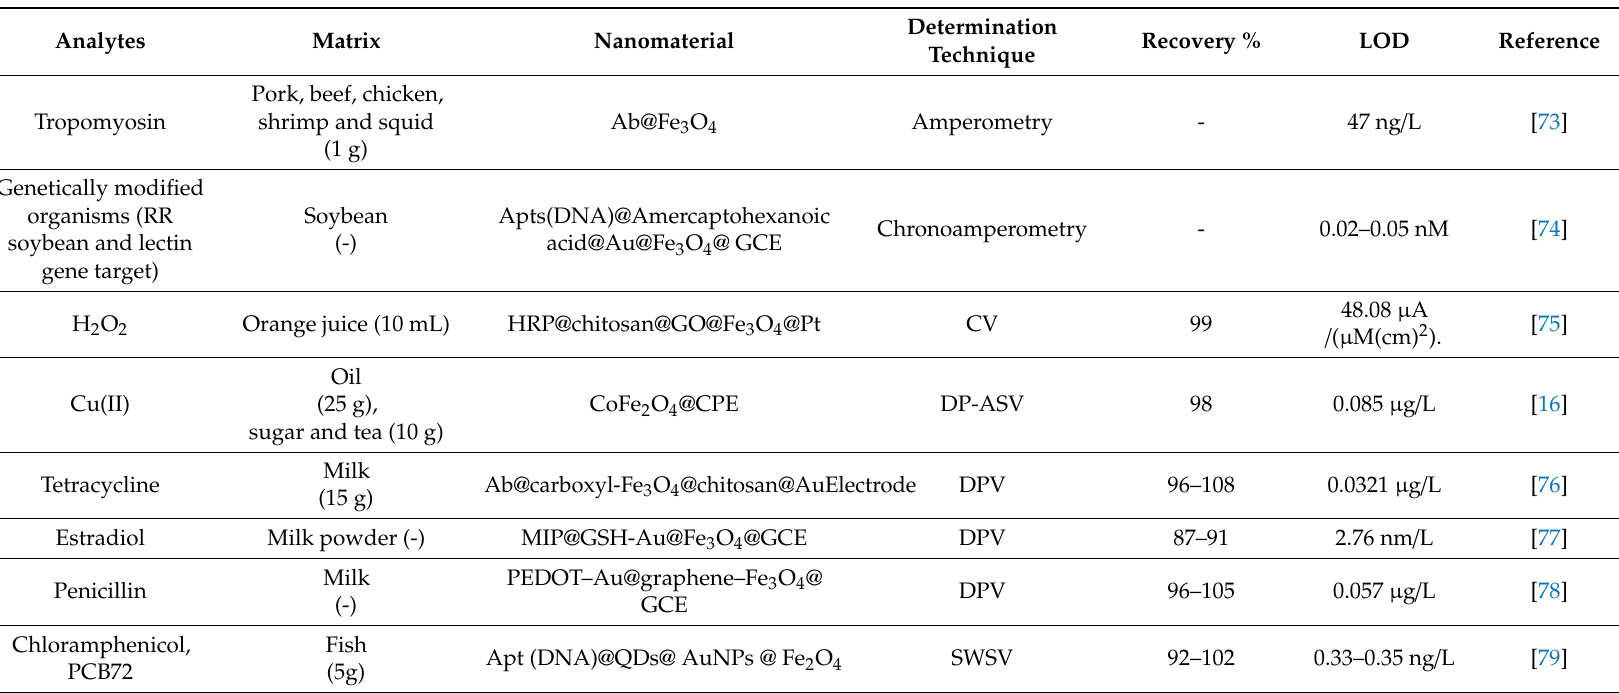
Table 5. Novel applications of magnetic nanoparticles based on electrochemical sensors in food analysis. Analytes Matrix Nanomaterial